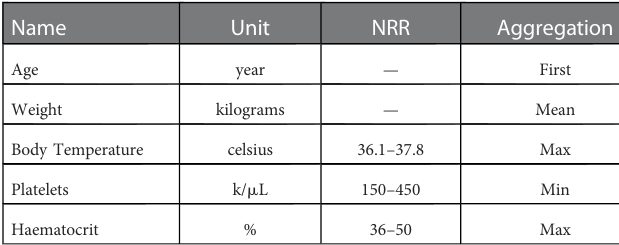
TABLE 1 Input features.